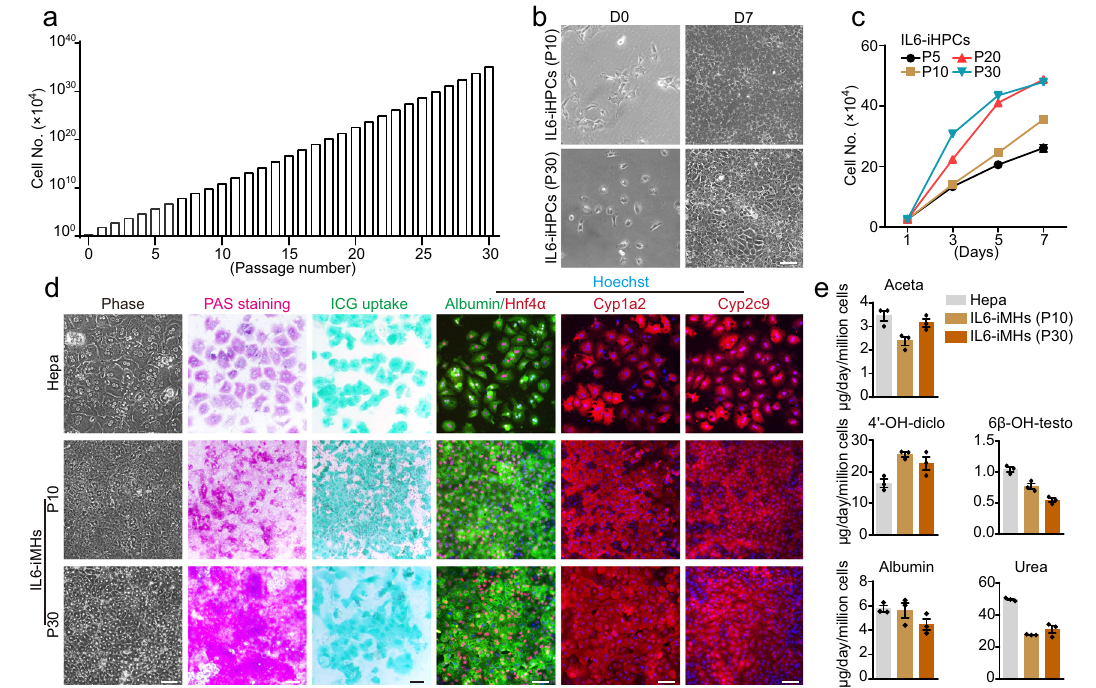
Fig. 2 | IL6 support long-term expansion of iHPCs without losing the differ- entiation capacity. a Calculated cumulative cell numbers of IL6-iHPCs for 30 passages. b Representative images of IL6-iHPCs (P10 and P30) cultured with IL6 at D0 and D7. c The growth curve of IL6-iHPCs from different passages. Data are Means±SEM ( n =4 independent experiments). d Representative phase contrast images, PAS staining, ICG uptake and immuno fl uorescence staining of hepatic markers Albumin (green), Hnf4 α (red), Cyp1a2 (red) and Cyp2c9 (red) in IL6-iMHs (P10 and P30), primaryhepatocyteswereused ascontrol. Nuclei werestained with